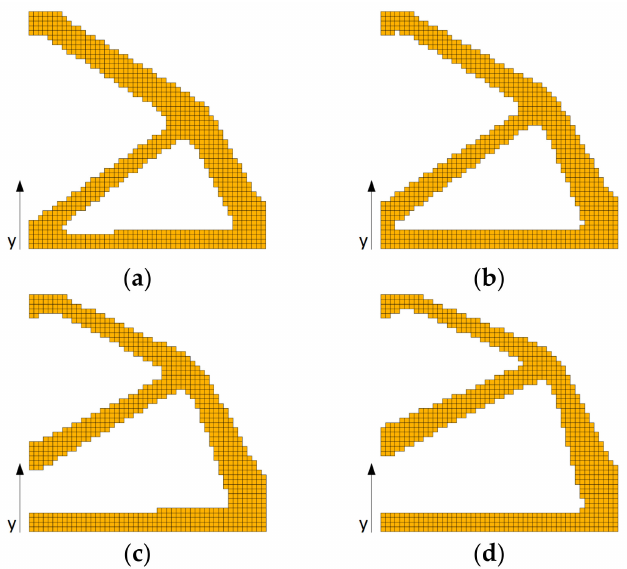
Figure 7. Final topologies obtained for square structure for the FGM-SIMP material interpolation scheme, y -direction of material gradation: ( a ) β = − 0.02, minimal compliance: 4.863 Nm; ( b ) β = − 0.04, minimal compliance: 9.328 Nm; ( c ) β = − 0.06, minimal compliance: 18.112 Nm; ( d ) β = − 0.08, minimal compliance: 35.210